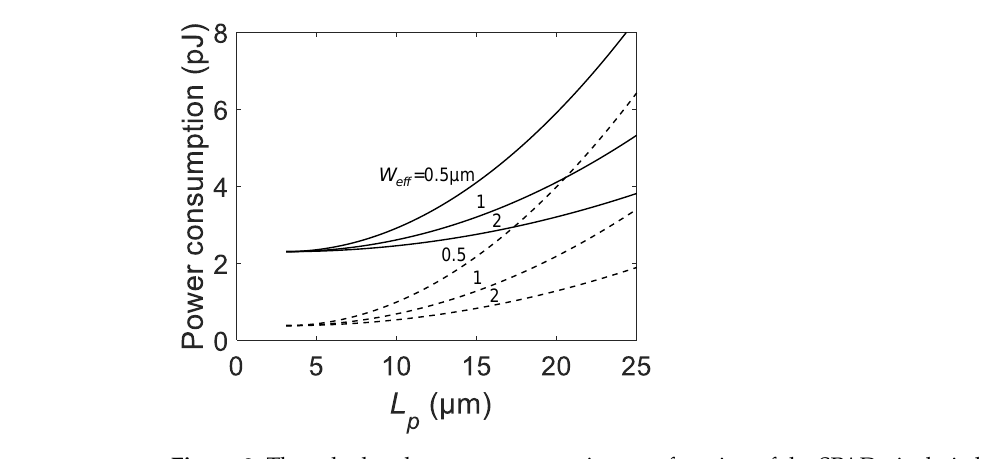
Figure 9. The calculated power consumption as a function of the SPAD pixel pitch L p for C 0 = 5 fF (dashed lines) and 30 fF (solid lines), active-to-active distance L a − a = 3 µ m, V B = 20 V, V ex = 3.3 V, and W ef f = 0.5, 1, and 2 µ m.